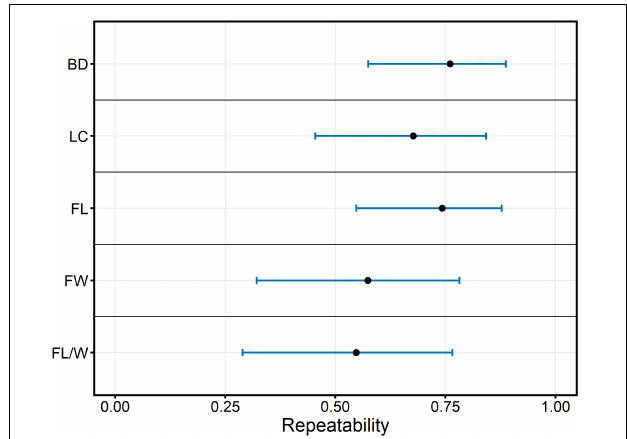
FIGURE 2 | Repeatability estimates (black dots) and 95% confidence intervals (blue bars) for wood and fiber properties. BD, Basic density; LC, Lignin content; FL, Fiber length; FW, Fiber width; FL/W, Fiber